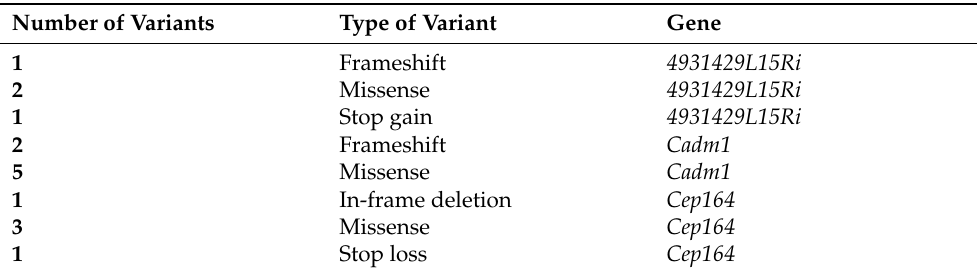
Table 4. The QTL located in chromosome 9 at 45.671-48.081Mb for mechanical nociception contains predicted deleterious variants in 3